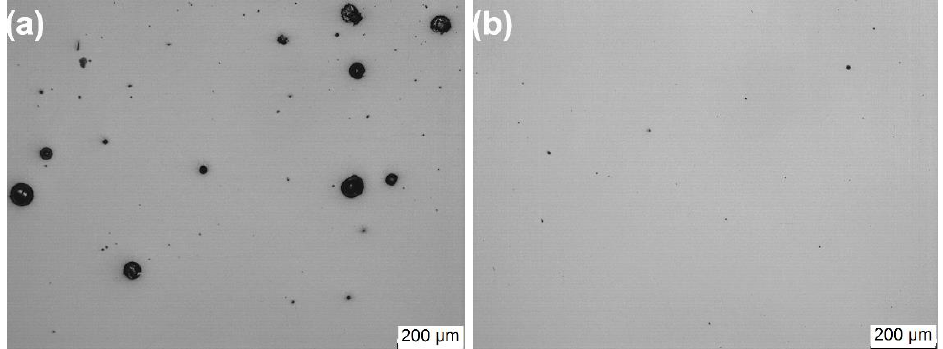
Figure 7. Micrographs of the cross-section of SLM cuboids with different process parameters. ( a ) power: 240 W, speed: 650 mm/s, and hatch distance of 0.09 mm. ( b ) power: 212.5 W, speed: 850 mm/s, and hatch distance of 0.11 mm.